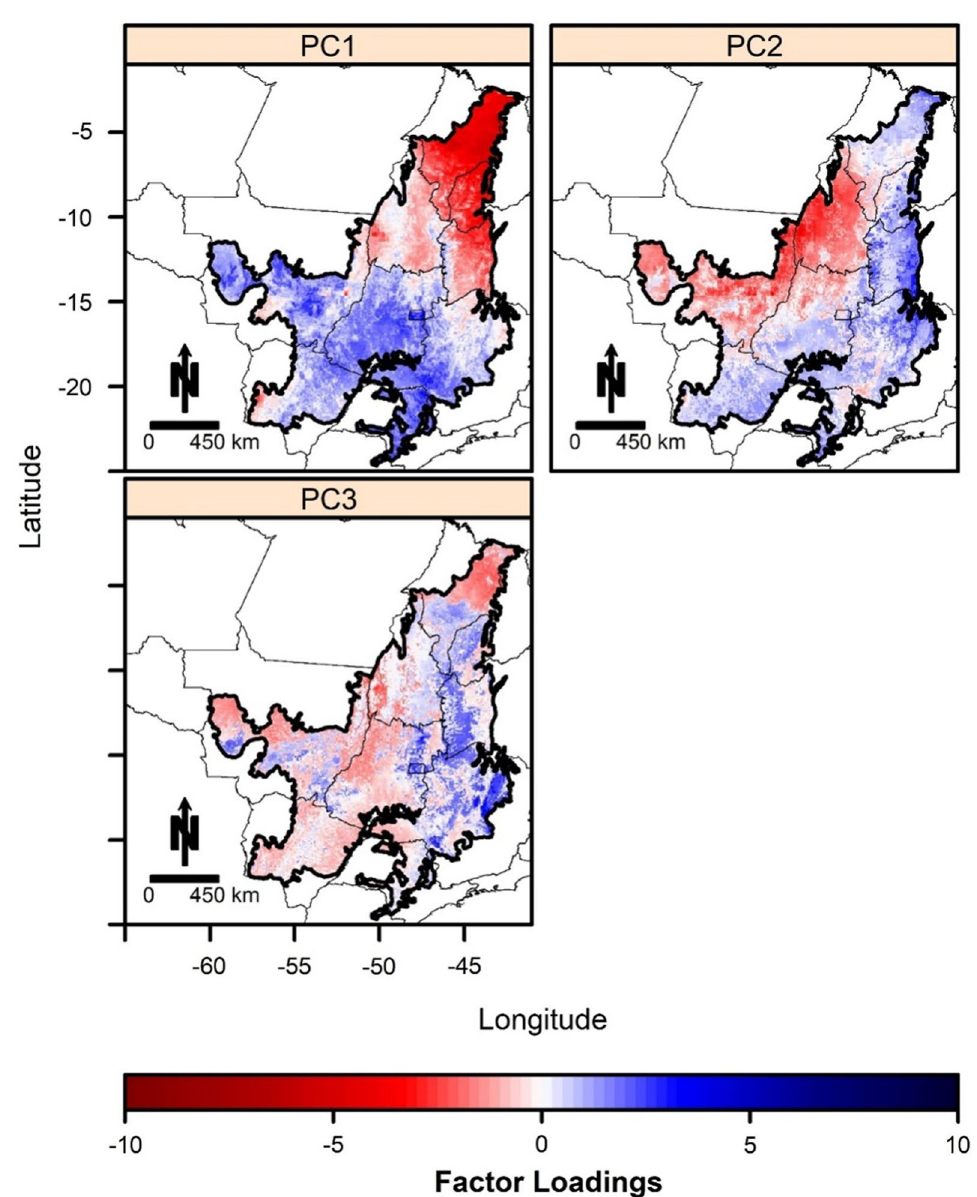
Fig. 4 Spatial factor loadings (scores) corresponding to each of the three PC: PC1 (top left panel), PC2 (top right panel), and PC3 (bottom left panel). The colors represent the influence of each PC’s positive (blue) or negative (red). The scores range in value